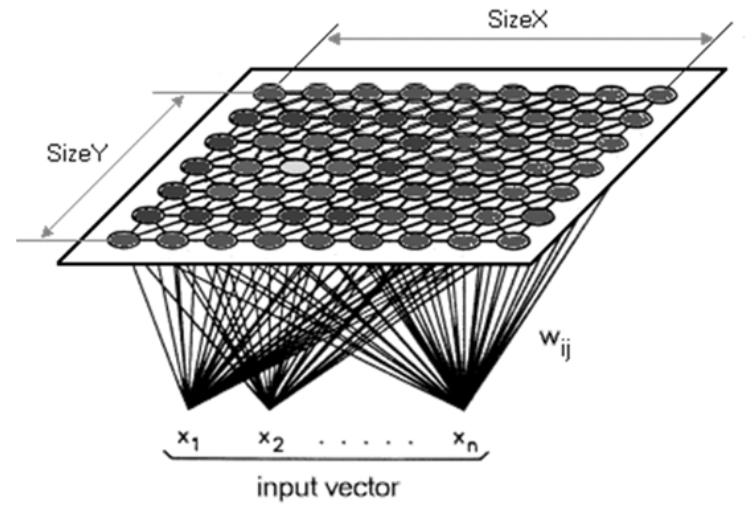
Figure 9. Example of kohonen network arrangement.